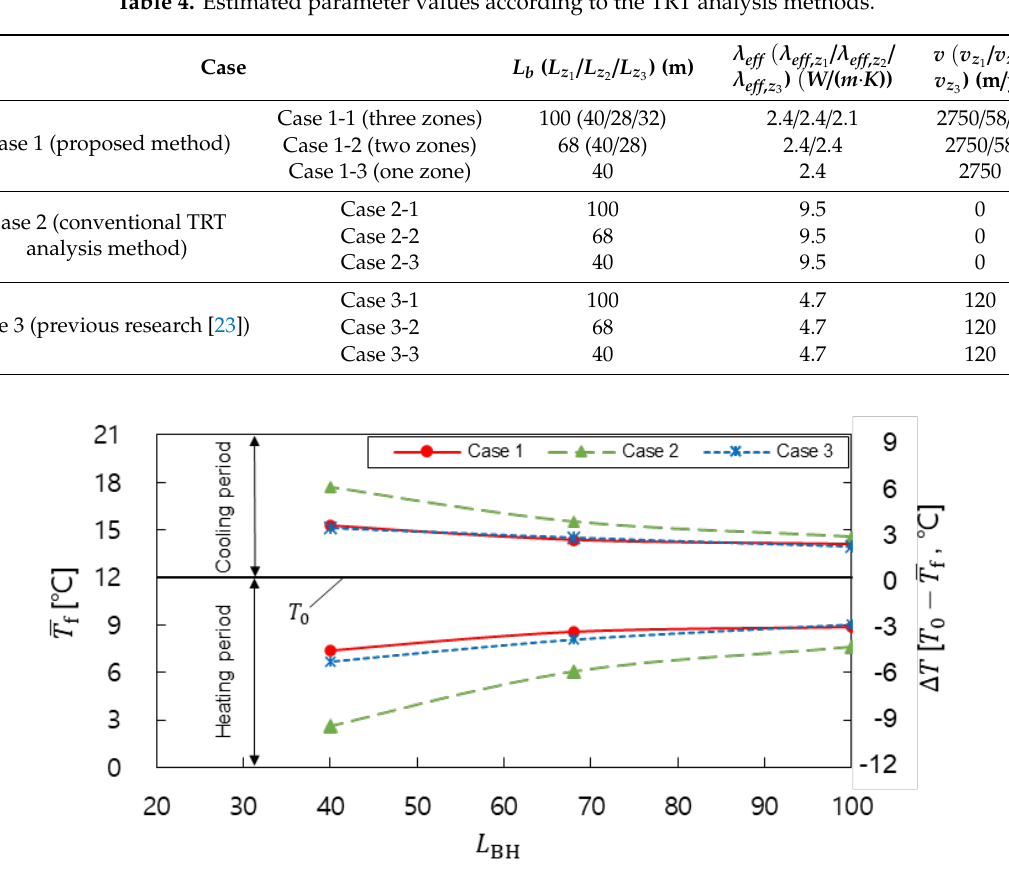
Figure 15. Average temperature of the circulating fluid during the heating and cooling seasons according to the borehole size.